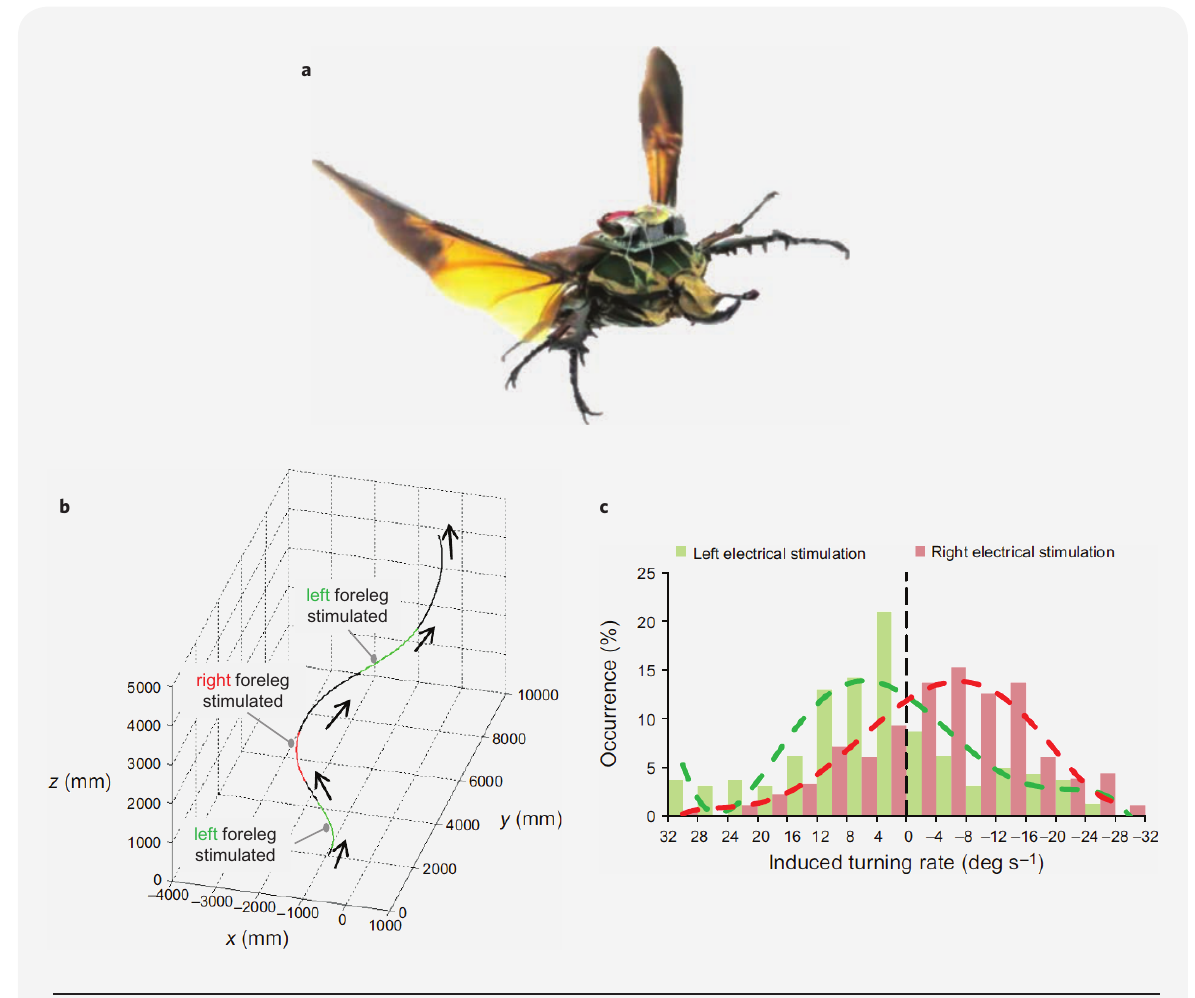
Figure 7. Flight directional control via stimulation of the foreleg protraction muscle. (a) Backpack mounted on a fl ying beetle to apply stimulation via two wire electrodes into each foreleg protraction muscle. (b) Electrical stimulation in sequence of the left and right protraction muscles produced left and right turns, respectively, resulting in a zigzag fl ight path. The black trajectory segments indicate periods of no stimulation. The red and green trajec- tory segments indicate right and left stimulation periods, respectively. (c) Histogram of the turning rates induced by left (green) and right (red) foreleg stimulation. The green and red dashed lines represent the polynomial fi tted distribution of the turning rates induced during left and right stimulation, respectively. Positive values denote turning toward the left and negative values denote turning toward the